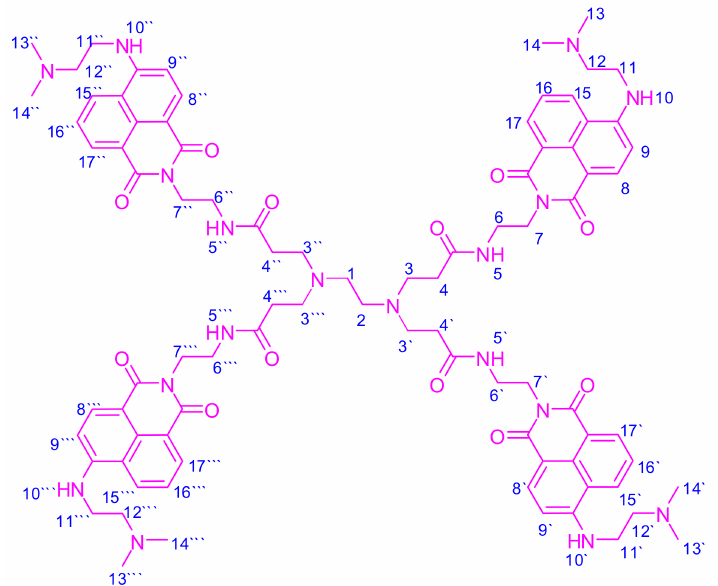
Figure 4. The FCD molecule’s structure with atom numbers.